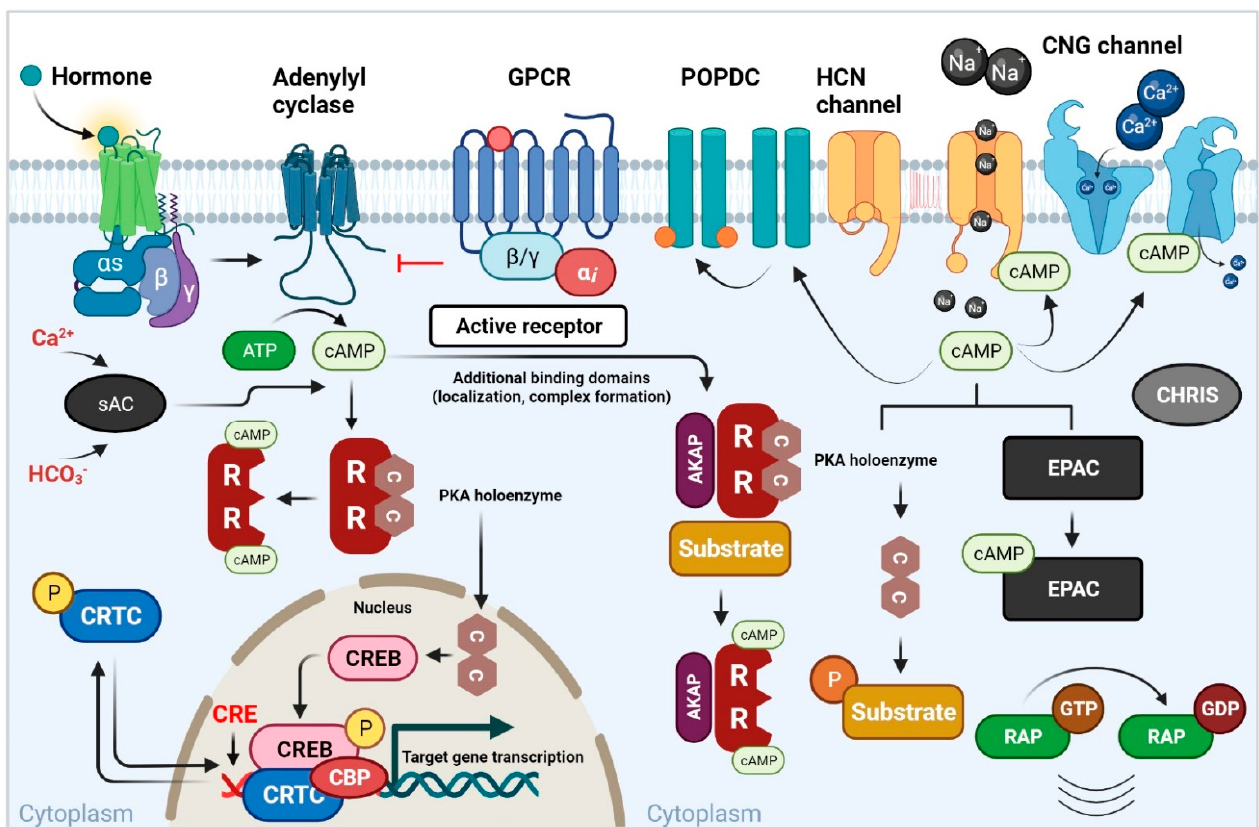
Figure 1. An overview of mammalian second messenger cAMP signaling pathways [10]. Up- stream stimulation of G α s-coupled GPCRs, which then activate AC to create cAMP, is required for signaling through the PKA pathway. The activation of G α i-coupled GPCRs inhibits the synthesis of AC and cAMP. Ca 2+ and HCO 3 − activate soluble AC (sAC), which leads to cAMP synthesis. The generation of cAMP in the cell is regulated by multiple ACs as well as its breakdown by PDEs. The tetrameric PKA holoenzyme is made up of two R subunits and two C subunits. Regulatory subunits and substrates are coordinated by AKAPs. Additional binding domains on AKAPs aid in the build- ing of protein complexes and allow them to be targeted to specific sites inside the cell. When cAMP binds to regulatory subunits, the holoenzyme dissociates, allowing catalytic subunits to phosphor- ylate substrates. CREB-mediated transcription is mediated by PKA. A hormone binds to G α s-linked GPCRs on the cell surface, stimulating cAMP synthesis and PKA activation through adenylyl cyclase signaling. Adenylyl cyclase and cAMP generation are inhibited when G α i-coupled GPCRs are activated. C subunits translocate to the nucleus to phosphorylate CREB on serine 133 when they are active. To enhance binding to CREs and transcription of target genes, phosphorylated CREB binds coactivators such as CBP. CREB-mediated transcription is regulated by other coactivators such as CRTCs. Phosphorylation of CRTCs by other kinases causes them to be sequestered in the cytoplasm, while dephosphorylation by phosphatase allows them to be translocated to the nucleus. Beyond PKA, cAMP binds to and activates effectors. cAMP modulates channel opening and cation currents through binding to CNG ion channels. HCN channels bind cAMP to help membrane hy- perpolarization open the channel. In the Ras-associated protein (RAP) family of small GTPases, cAMP binds to EPAC to enable the exchange of GDP for GTP. POPDC proteins exist as dimers on the cell surface that bind cAMP. GPCR, G protein–coupled receptor; AC, adenylyl cyclase; PKA, protein kinase A; PDE, phosphodiesterase; AKAP, A-kinase anchoring protein; CREB, cAMP